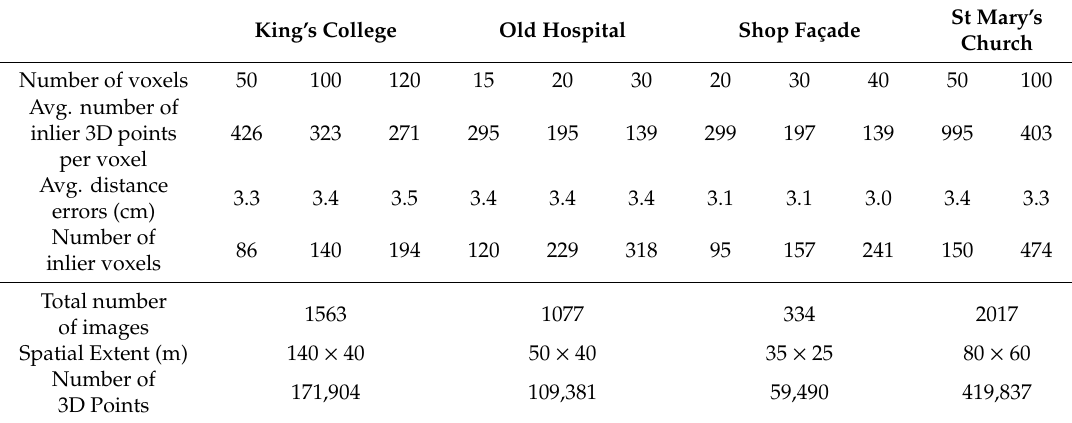
Table 1. Summary of the key scene representation metrics for the scenes from the Cambridge Landmarks dataset [3], according to the number of